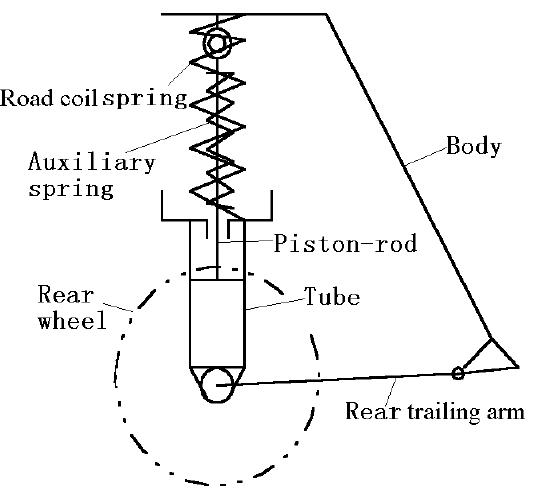
Fig. 2. The motion mechanism of a rear suspension in the wheel plane.